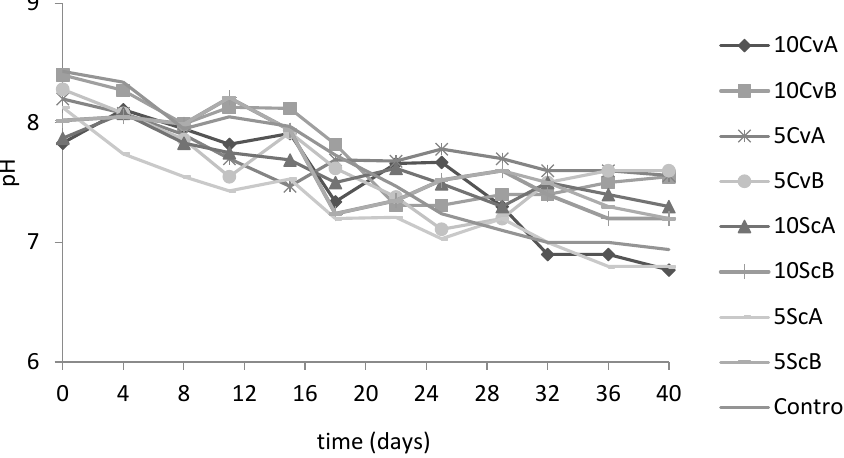
Figure 6. pH values observed during the repeated fed-batch culture cultivation of microalgae. The lines indicate the days when the culture was fed with a new dose of wastewater.